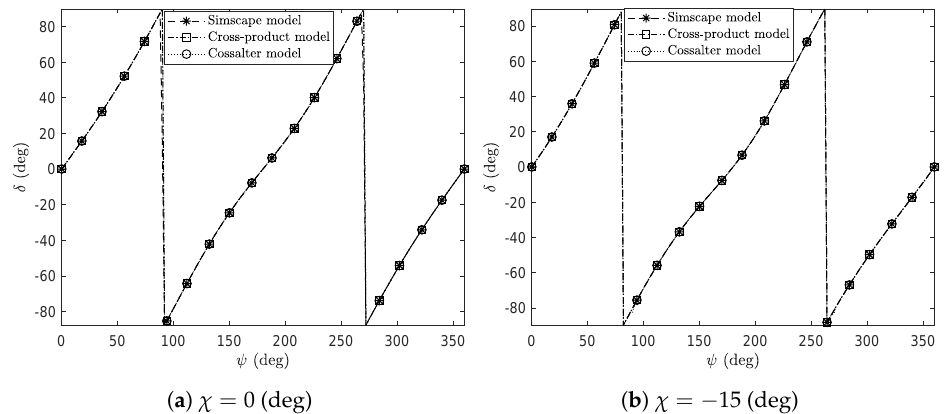
Figure 17. The absolute yaw angle of the front assembly denoted with δ . ( a ) considers the case of a constant roll angle of the rear frame equal to zero. ( b ) presents the case of a constant roll angle of the rear frame equal to χ = − 15 (deg).